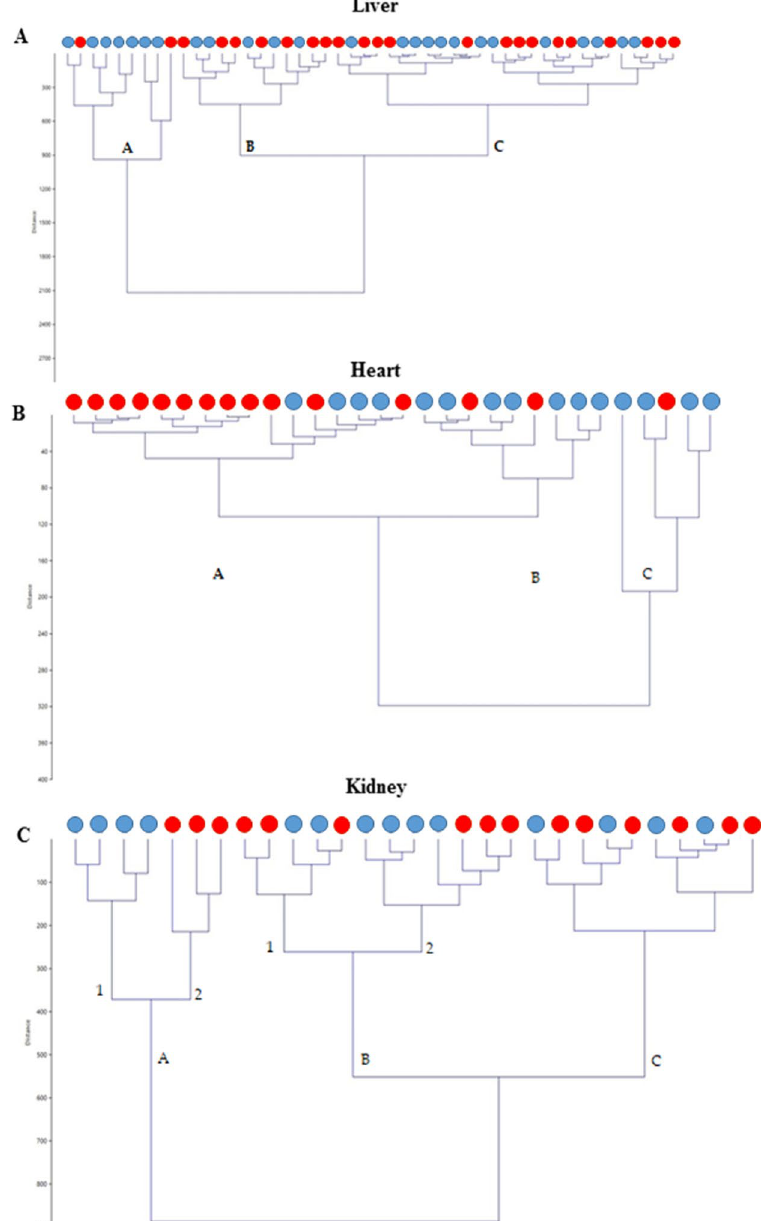
Figure 6. Cluster analysis depicting liver ( A ), heart ( B ) and kidney ( C ) sample distribution on the basis of Ward’s method used for hierarchical clustering. All dendrograms were constructed using together male and female samples per each organ metabolomic dataset. Male samples are depicted using a blue dot while female samples are in